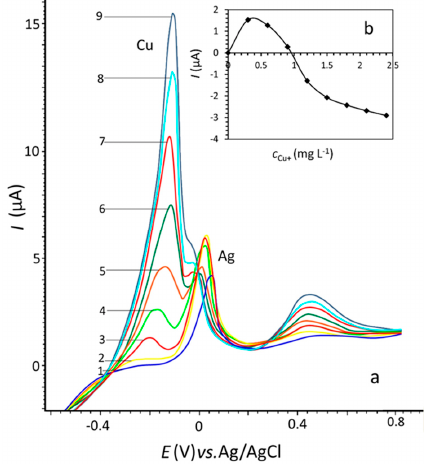
Figure 2. Current–voltage curves ( a ) and electrooxidation currents ( b ) of deposits containing silver and copper. Experimental conditions: medium of 1 mol L − 1 HCl + NH 4 OH, E e = − 0.7 V; τ e = 120 s; v = 0.06 V s − 1 ; c Ag + = 2 mg L − 1 ; c Cu 2+ , mg L − 1 ; (1) 0, (2) 0.3, (3) 0.6, (4) 0.9, (5) 1.2, (6) 1.5, (7) 1.8, (8) 2.1, and (9)